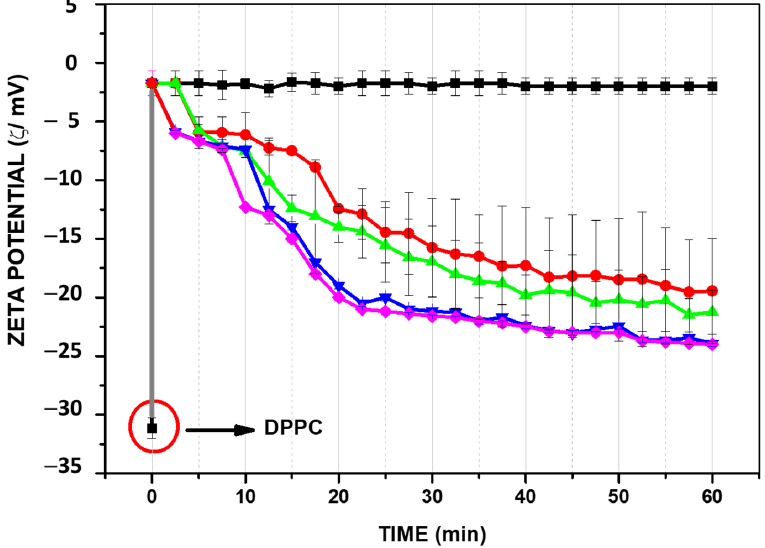
Figure 6. Changes of zeta potential of DPPC liposomes after the addition of PLA 2 in the presence of Ca +2